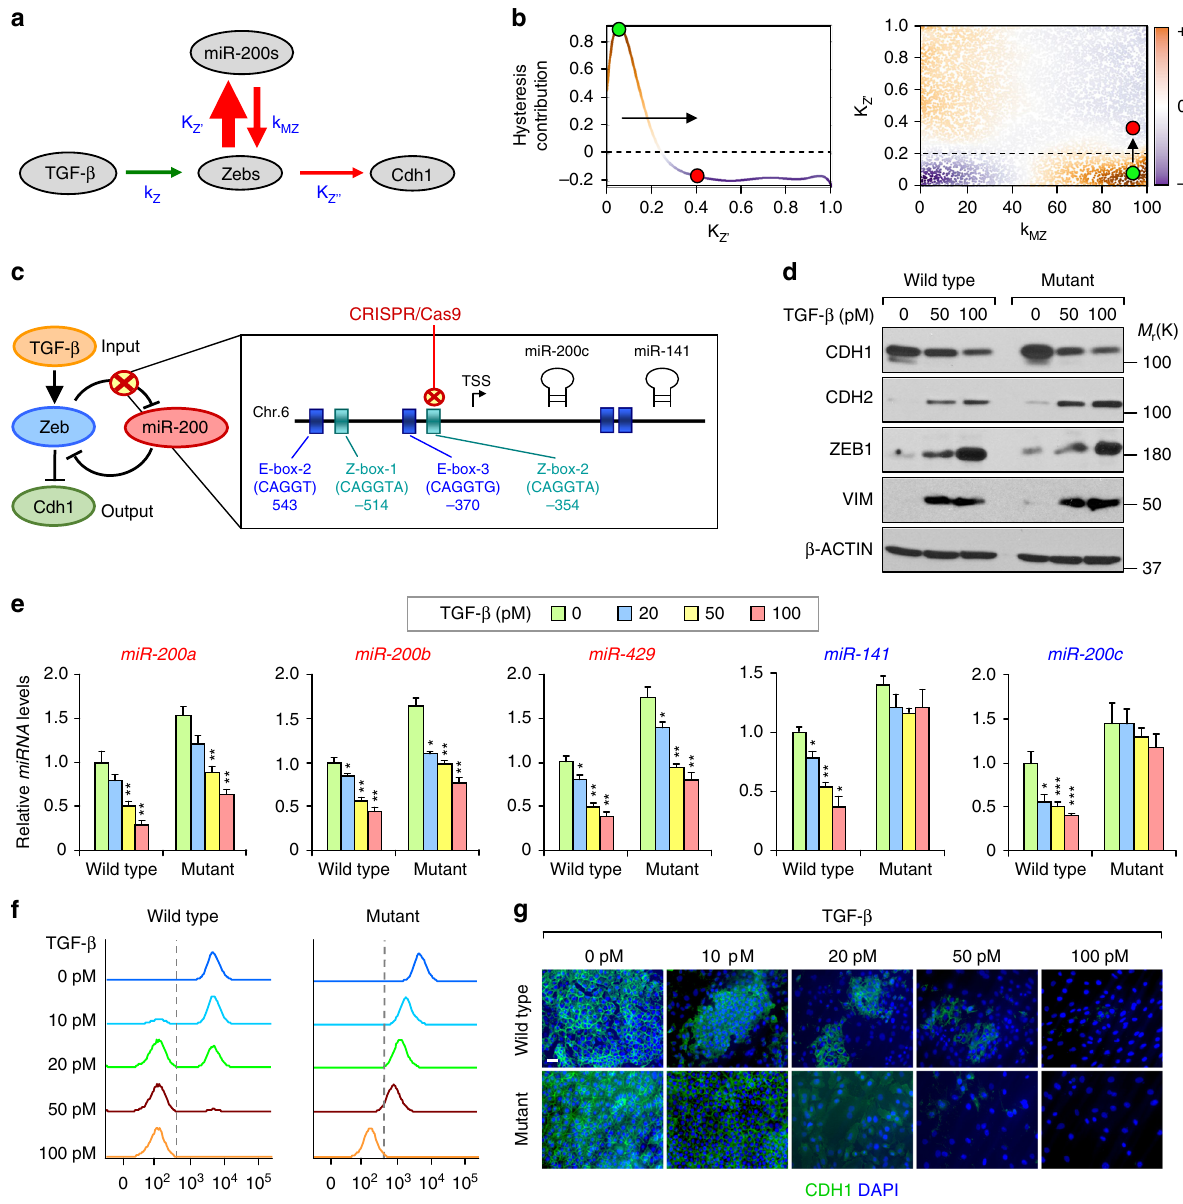
Fig. 2 ZEB1 repression of miR-200s tightly controls hysteresis during EMT. a Schematic illustration of the strength of interaction constants and reaction coef fi cients: k Z , K Z ′ , K Z ′′ and k MZ. The thickness of the arrows represents the magnitude of the interaction strength (sensitivity index). b High dimensional model representation (HDMR) component functions of hysteresis contribution in K Z ′ (left panel; fi rst-order) and K Z ′ vs k MZ (right panel; second-order). The green dot denotes a region with hysteresis (orange background) and red dot a region without hysteresis (blue background). The arrow represents a minimal modi fi cation of the K Z ′ that eliminates hysteresis. c Representation of the Z-box-2 deleted using CRISPR-Cas9 in NMuMG and EpRAS cells generating the corresponding mutant cells. d Western-blot analysis of EMT markers in wild type and mutant NMuMG clonal cells at the indicated concentration of TGF- β for 72 h. e qRT-PCR analysis of the expression levels of, cluster-1 (red) and cluster-2 (blue) miR-200s family members in wild type and mutant NMuMG cells ( n = 3 biological replicates) treated with the indicated concentrations of TGF- β for 72 h. f Flow cytometry analysis and g immuno fl uorescence analysis of CDH1 expression in NMuMG clones after treatment with indicated concentrations of TGF- β for 72 h. Scale bar: 20 μ